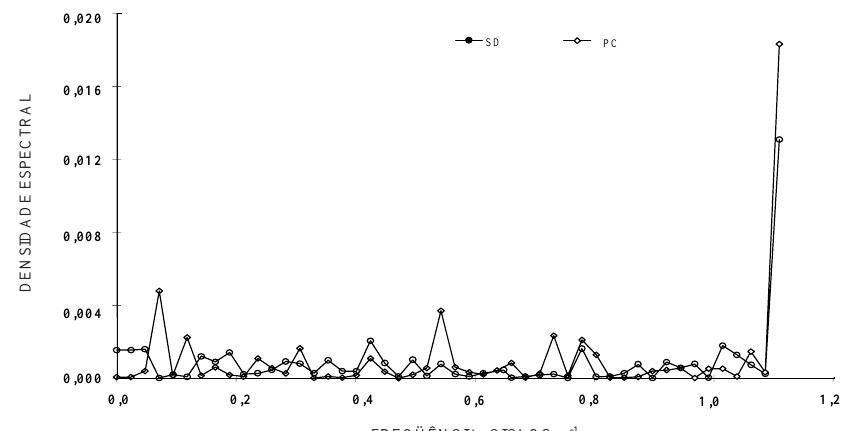
Figura 3. Densidade espectral da densidade do solo nos sistemas de semeadura direta (SD) e preparo convencional (PC) num Latossolo Roxo.